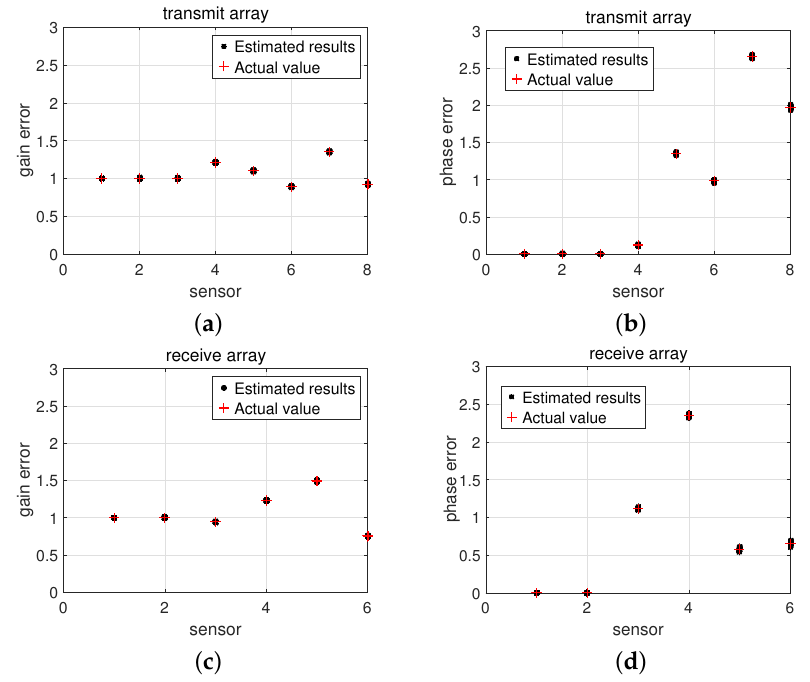
Figure 3. Gain-phase error estimation results, SNR = 20 dB, L = 200. ( a ) The gain error estimation of transmit array; ( b ) the phase error estimation of transmit array; ( c ) the gain error estimation of receive array; ( d ) The phase error estimation of receive